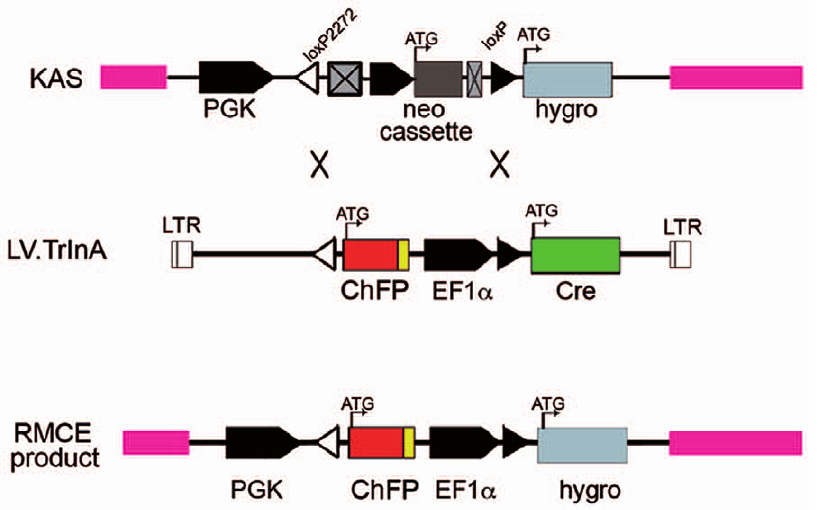
Figure 1. Cre recombinase-mediated insertion and cassette exchange strategy. Structure of the genetic landing pad (KAS) and the incoming construct (LV.TRINA) showing the more relevant elements: promoters PGK, EF-1 a and SV40 in the neo cassette (black arrows), reporter genes (coloured boxes), recombinase cre (green box), translation starting point (bended arrows), and polyA signals (crossed boxes). Triangles represent the loxP (black) and lox2272 (white) sites. ROSA26 homology arms are pink-colored and lentiviral LTRs drawn as clear boxes flanking the KAS and TRINA cassette respectively. For simplicity the CHYSEL and multicloning site downstream of the neo cassette are not indicated. The expected resulting endpoints after RMCE reaction are depicted below. Symbols are kept for simplicity. ChFP, cherry fluorescent protein; LTR, long terminal repeat.